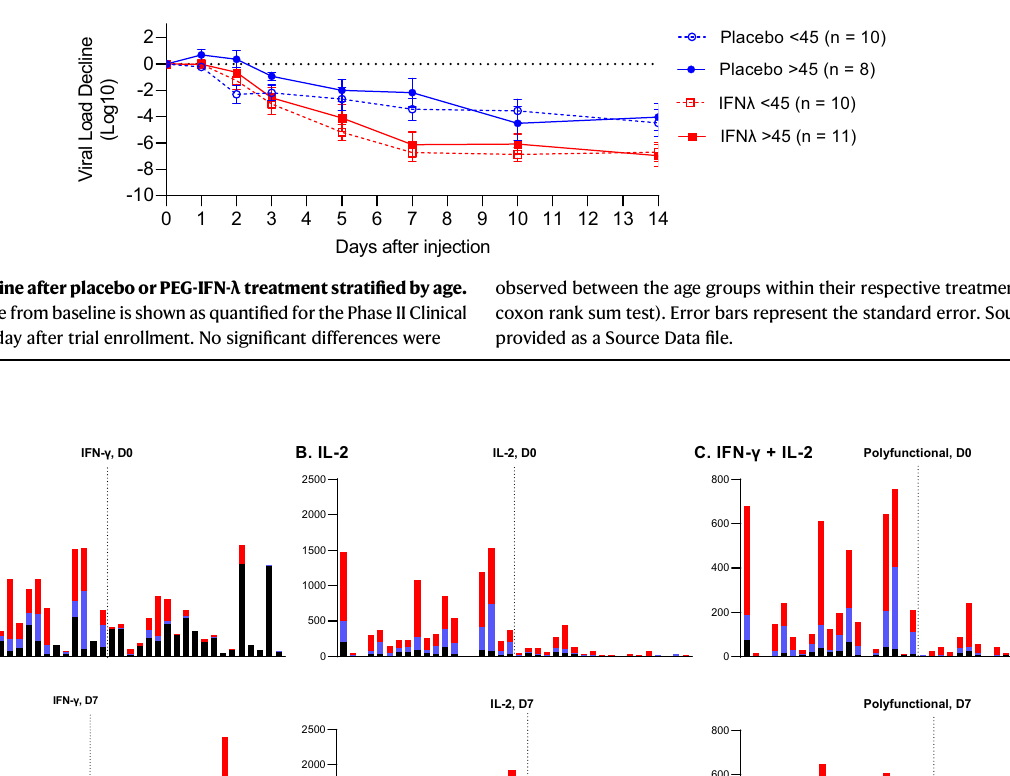
Fig.5|ViralloaddeclineafterplaceboorPEG-IFN- λ treatmentstrati fi edbyage. Meanviralloaddeclinefrombaselineisshownasquanti fi edforthePhaseIIClinical trial by RT-qPCR per day after trial enrollment. No signi fi cant differences were